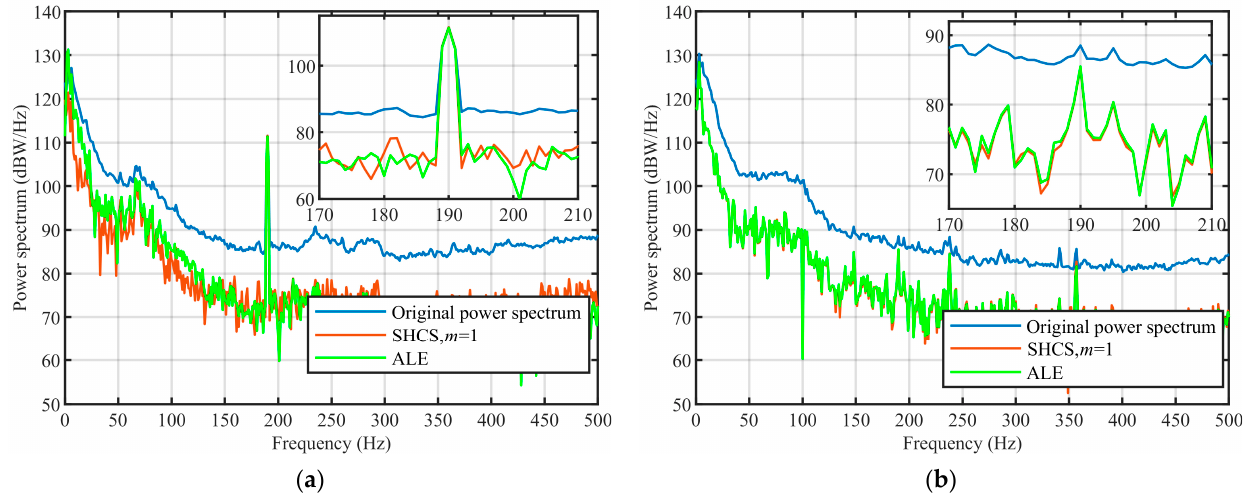
Figure 12. SHCS method compared with ALE method: ( a ) 10 km; ( b ) 100 km.